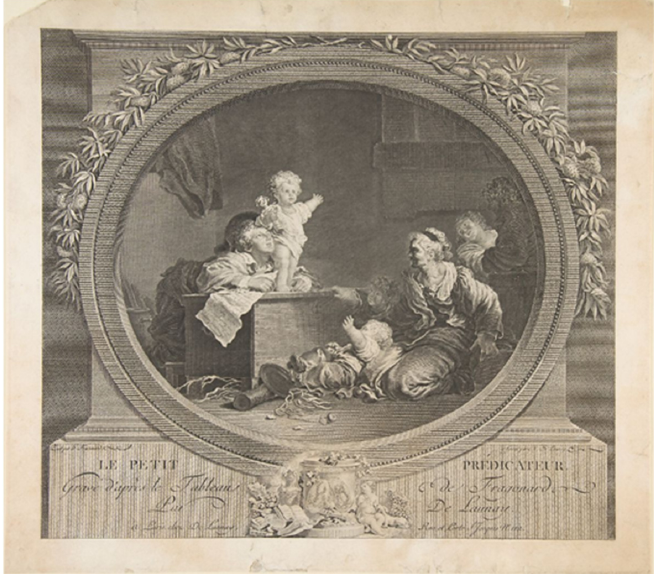
Figure 16. Nicolas de Launay after Jean Honoré Fragonard, Le Petit Predicateur, 1790, Ething and engraving, 26.8 cm × 30.2 cm, Metropolitan Museum of Art, New-York, The Elisha Whittelsey Collection, The Elisha Whittelsey Fund, 1958.